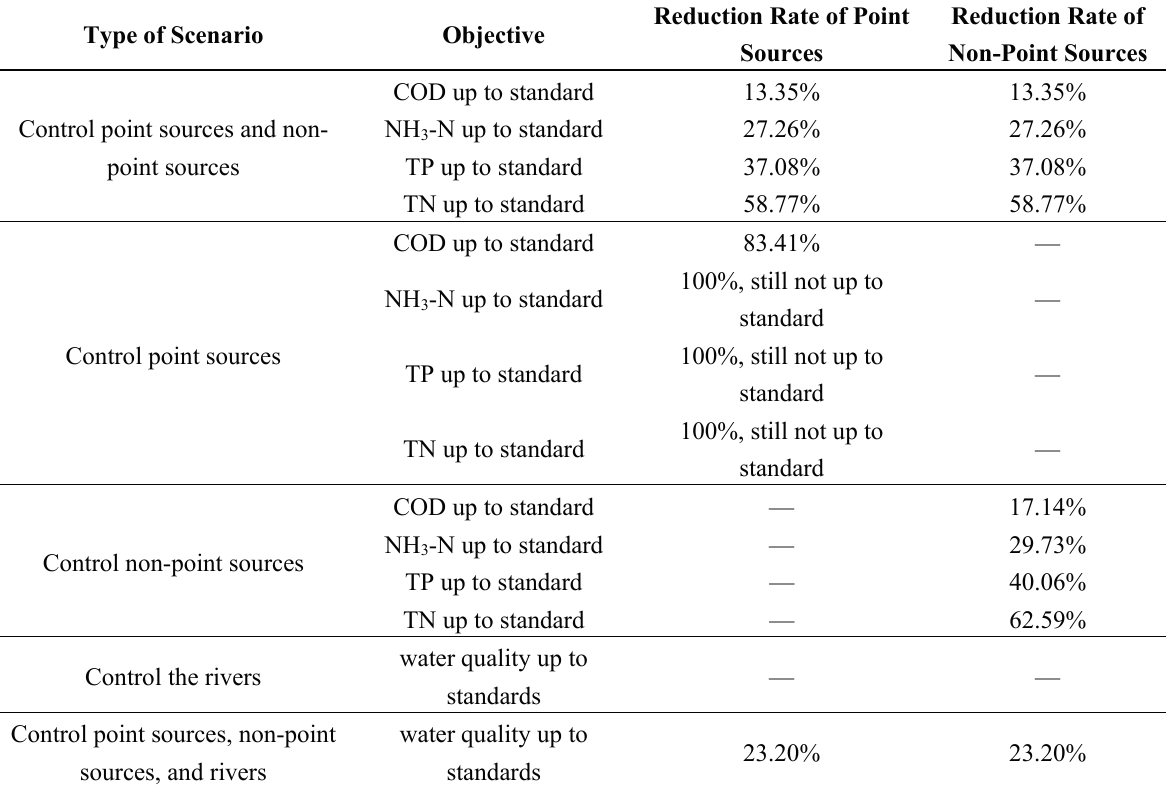
Table 8. Simulation results for various load reduction